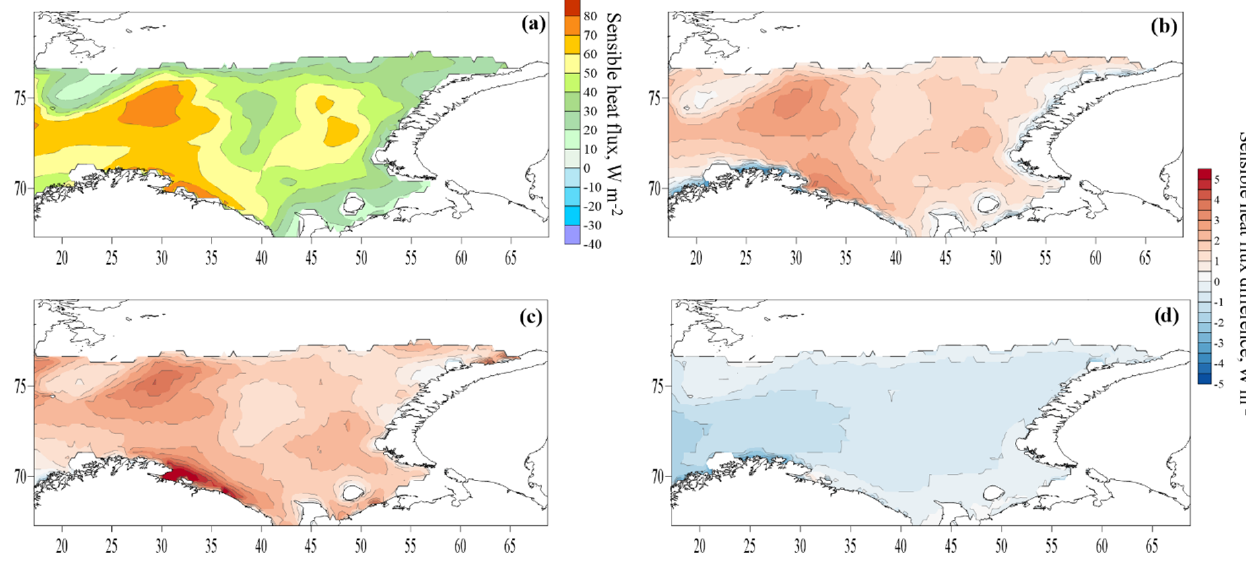
Figure 14. Mean sensible heat flux in experiment C55 (a) and the flux difference in experiments T1–C55 (b) , O2–C55 (c) and D3–C55 (d) during storms.